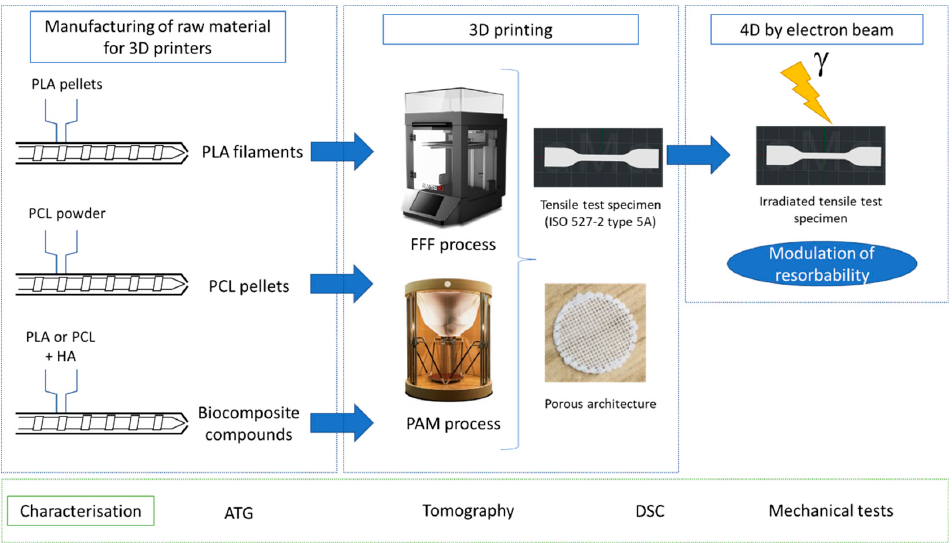
Figure 1. Schematic diagram of the overall experimental section, from materials preparation to characterization tests.